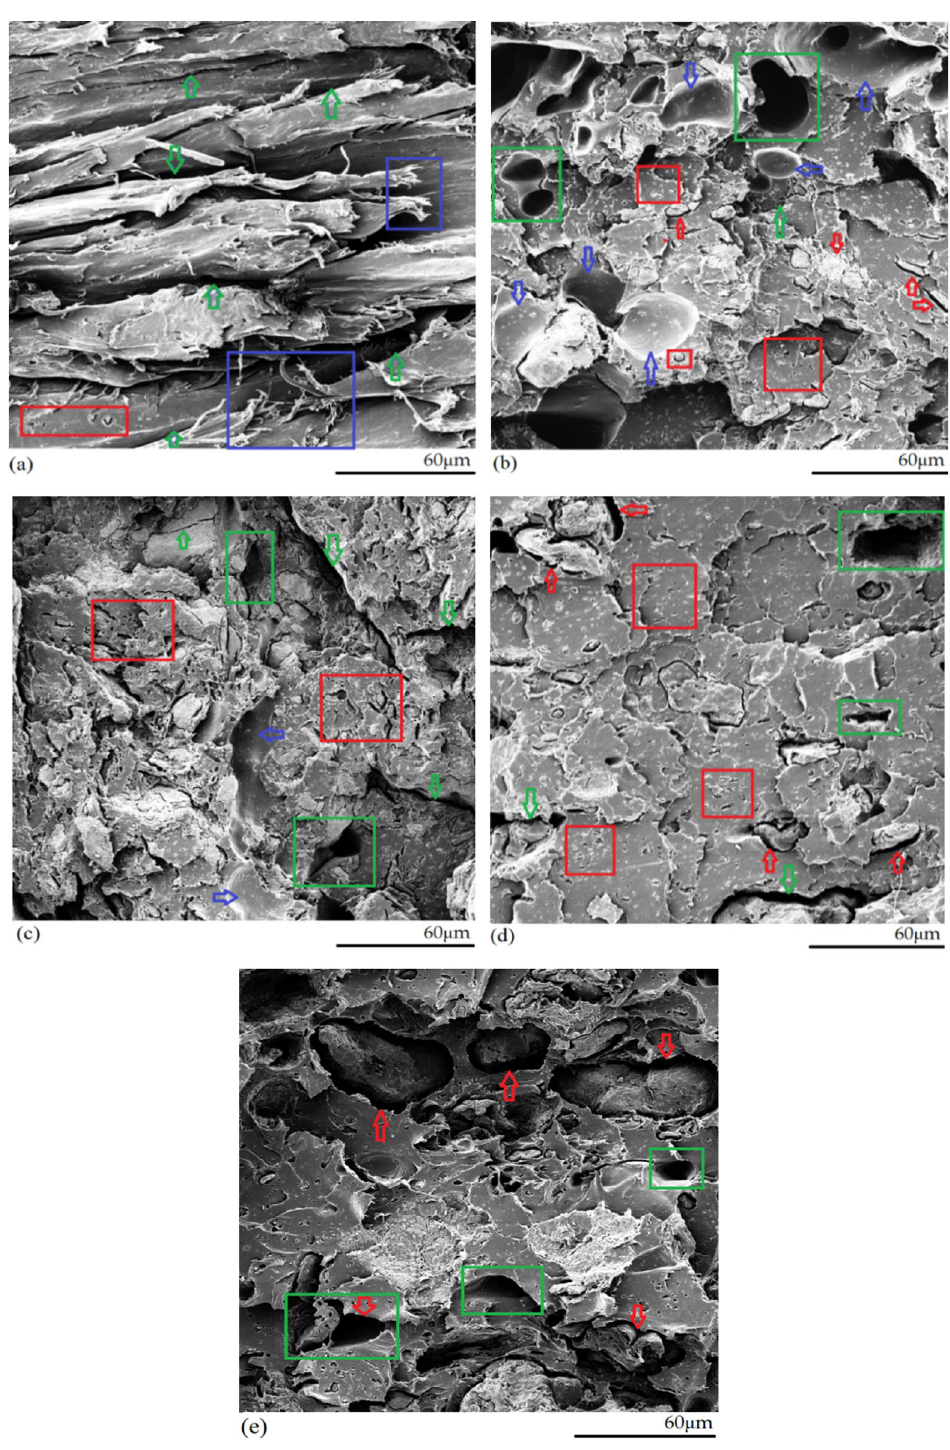
Figure 8. Morphology of the tensile fractured surface of the PLA/WS/HA composites after being immersed in deonized water for 6 weeks: ( a ) W3H3, ( b ) W3H8, ( c ) W3H15, ( d ) W8H3 and ( e )